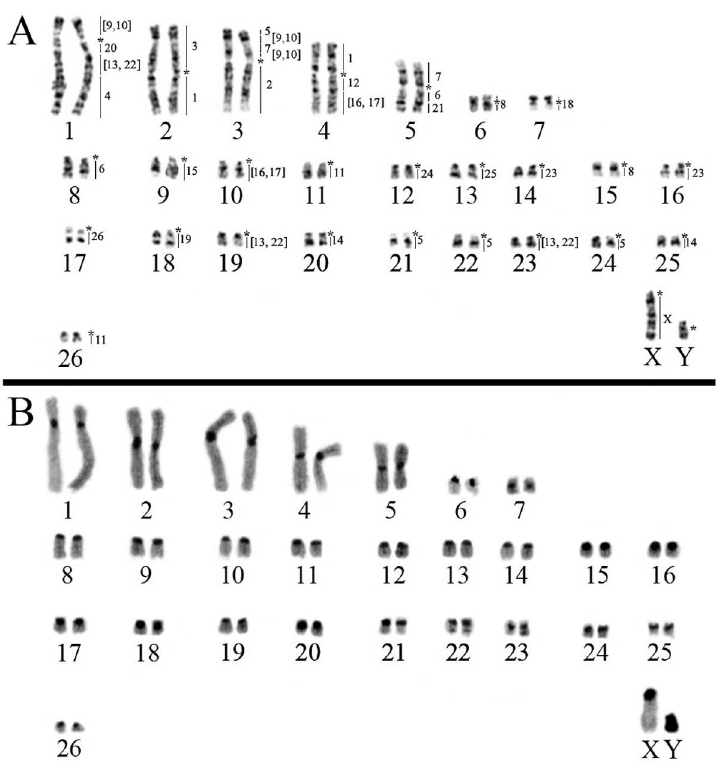
Fig 3. Neacomys sp. B (2n = 54/FN = 66). A) G-banding with chromosome paintingwith HME probes. B) C- banding.( * ) Indicates